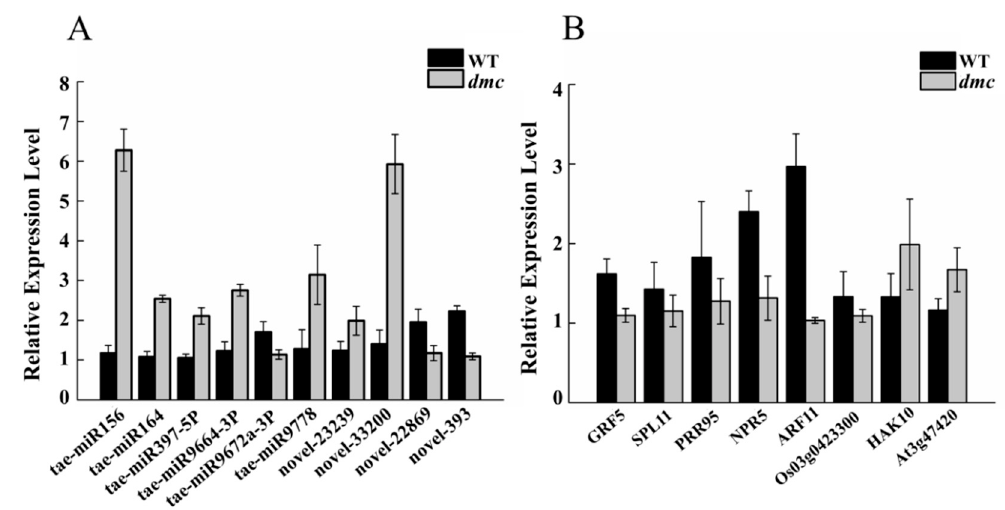
Figure 11. The expression profiles of ten DEMs and eight of their target DEGs. ( A ) The expression profiles of ten DEMs; ( B ) The expression profiles of eight target DEGs. GRF5 was targeted by novel-23239, novel-33200; SPL11 was targeted by tae-miR156; PRR95 was targeted by tae-miR9778; NPR5 was targeted by tae-miR9664-3P; ARF11 was targeted by novel-23239; Os03g0423300 was targeted by tae-miR397-5P; HAK10 was targeted by tae-miR9672a-3P; At3g47420 was targeted by novel-22869 and novel-393.